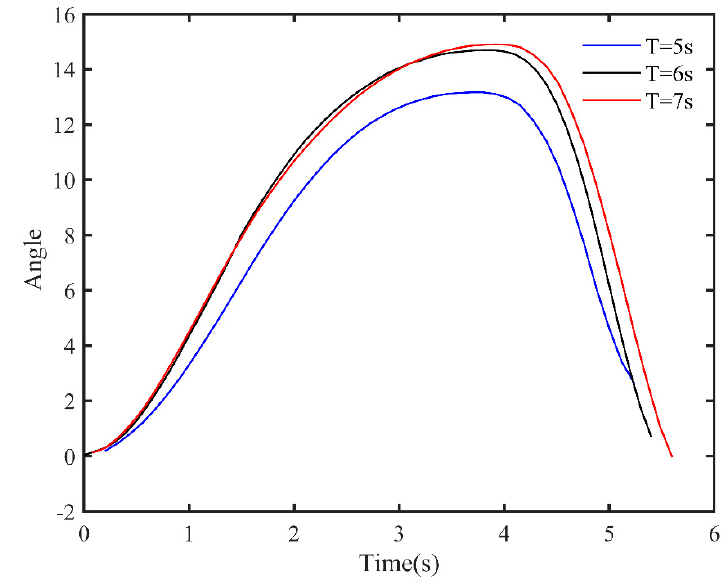
Figure 7. Power with different flapping-panel lengths.